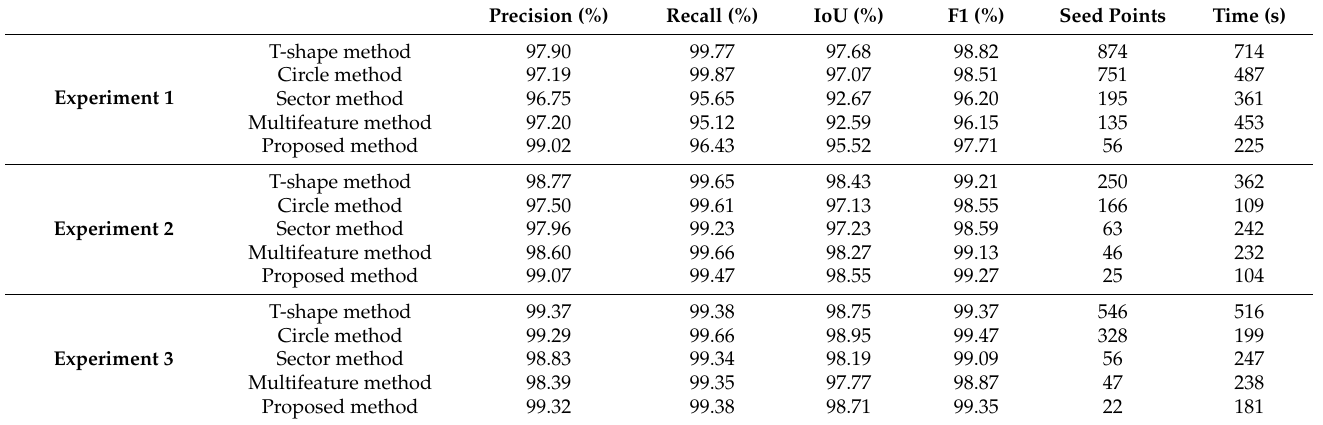
Table 2. Comparative results of the five methods analysed in the experiment. Precision (%) Recall (%) IoU (%) F1 (%) Seed Points Time